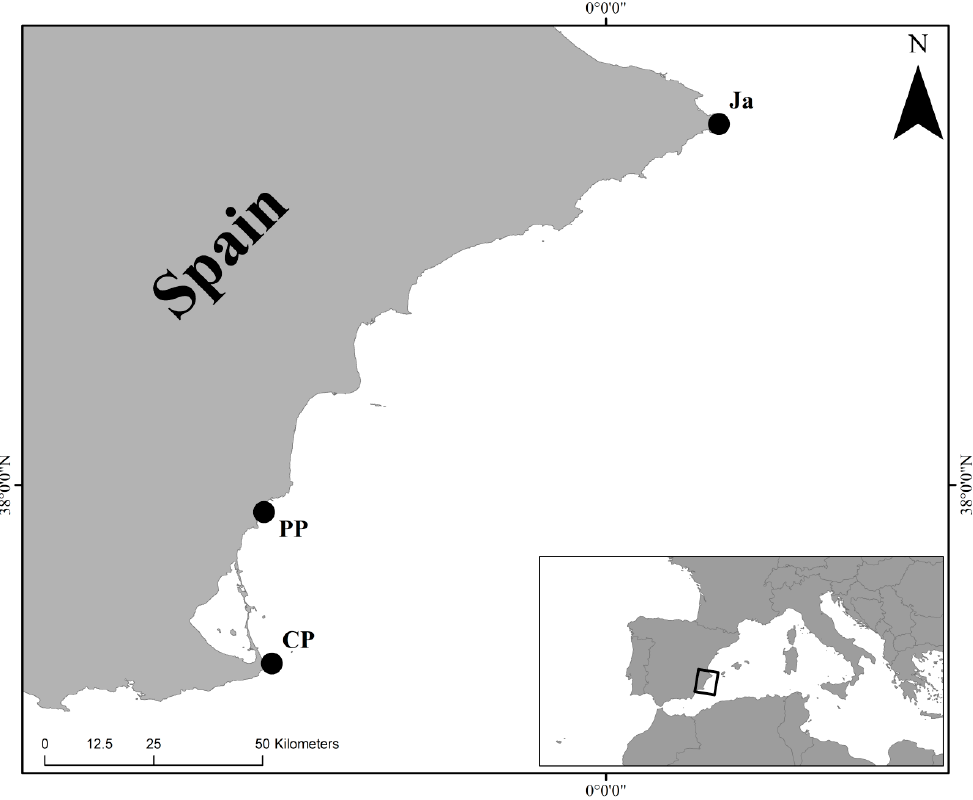
Figure 1. Map of the Mediterranean Spanish coast showing the geographical position of the three sampling sites: Cabo de Palos (CP), Punta Prima (PP) and Jávea (Ja).